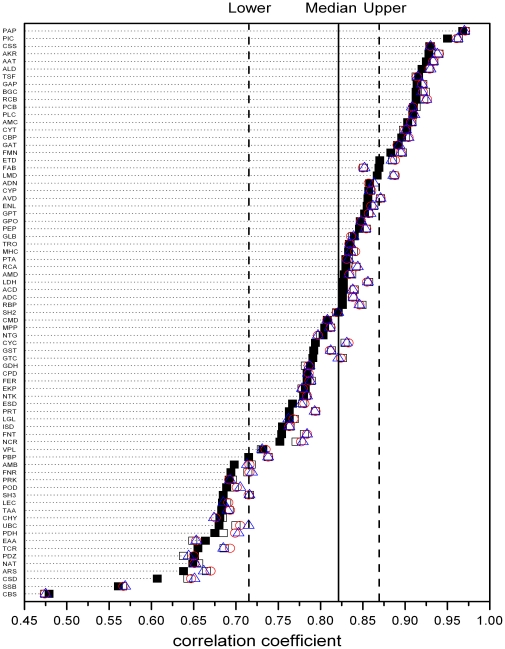
The sequence-structure correlation changes slightly under different substitution similarity assessing method.For all the 75 families, the bilinear multiple correlation coefficients produced by using PNI (▪), PNS-BLOSUM50 (□), PNS-BLOSUM62 (○) and PNS-BLOSUM80 (△) matrix differ slightly with each other. The solid line stands for the medians of the bilinear multiple correlation coefficients of PNI, SNG and RNSD, and the left and right dashed lines stand for the upper and down quartiles respectively.